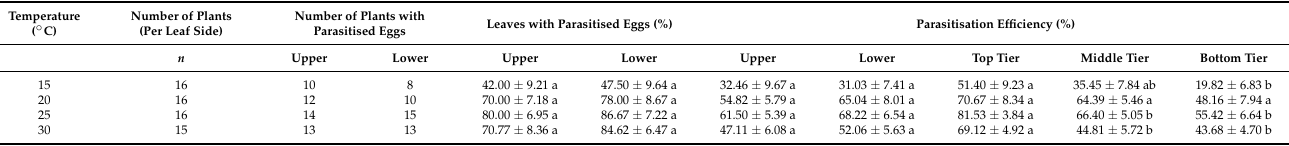
Table 2. Location of Ephestia kuehniella eggs parasitised by Trichogramma achaeae : mean ( ± SEM) percentage of leaves with parasitised egg per plant and parasitisation efficiency (percentage of parasitised eggs) by side of leaf (upper or lower) or leaf placement on plants at four constant temperatures. Different letters indicate significantly differences between Upper and Lower leaf side and/or between Top, Middle and Bottom leaf tier within temperatures, respectively ( p < 0.05, Wilcoxon rank sum test).